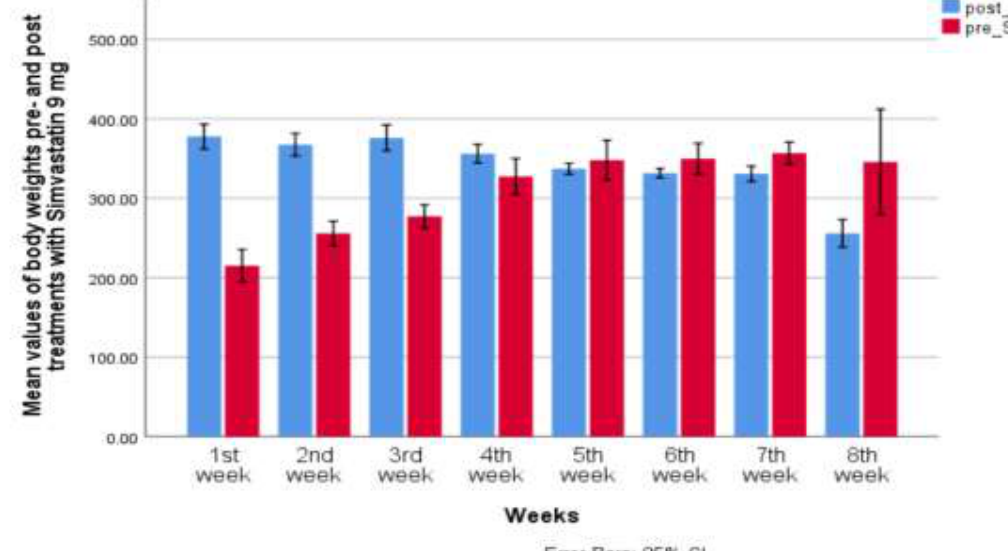
d. Detection of UCP1 protein in iBAT after eight weeks treatment with omega-3 alone.